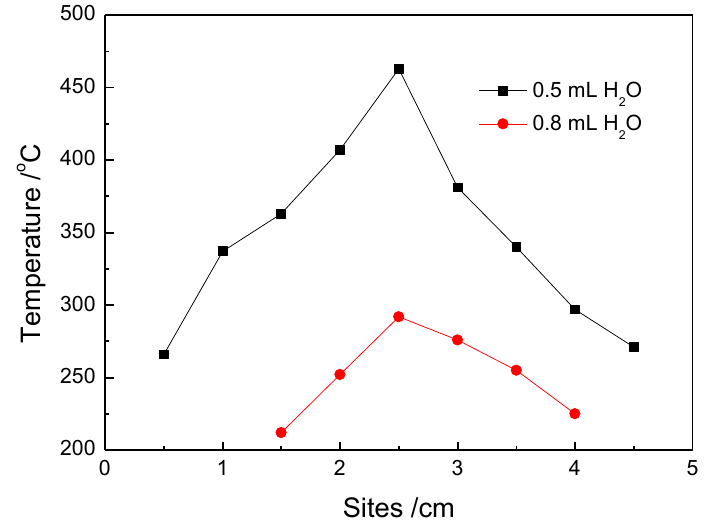
Figure 7. Temperature variation of the catalyst disc surface under different H 2 O contents. Conditions: 0.1 MPa CO 2 , concentrating ratio of 800, measured at noon.